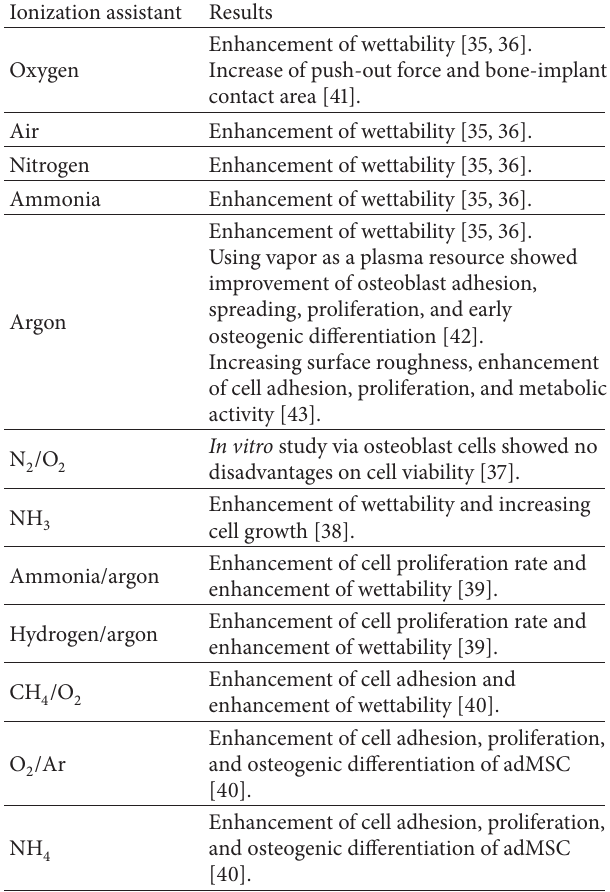
Table 2: Different ionization assistants which have been used for improving the bioactivity of PEEK via plasma